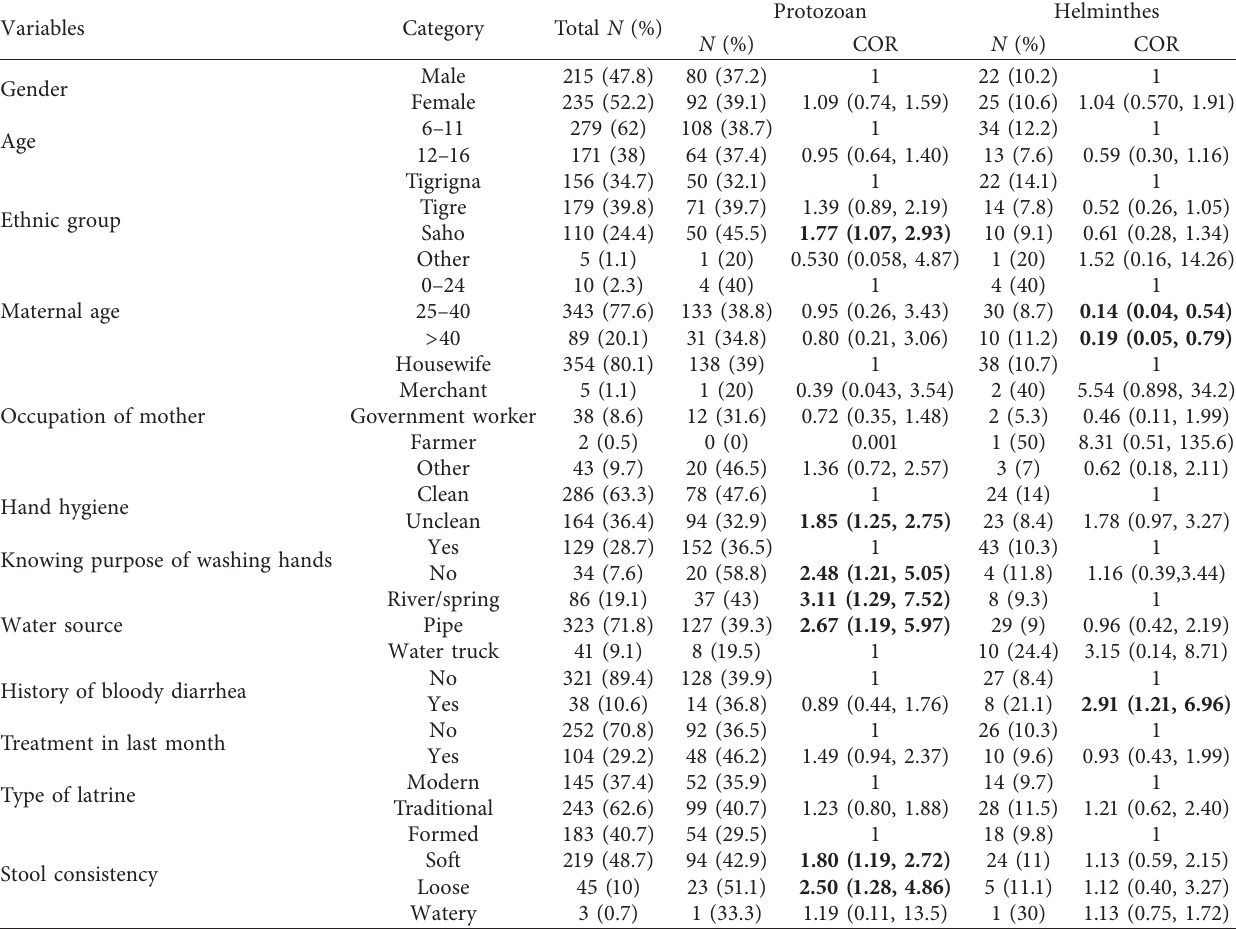
Table 3: Potential risk factors associated with intestinal parasitic infections in Ghindae area, Eritrea, 2018 ( n � 450).